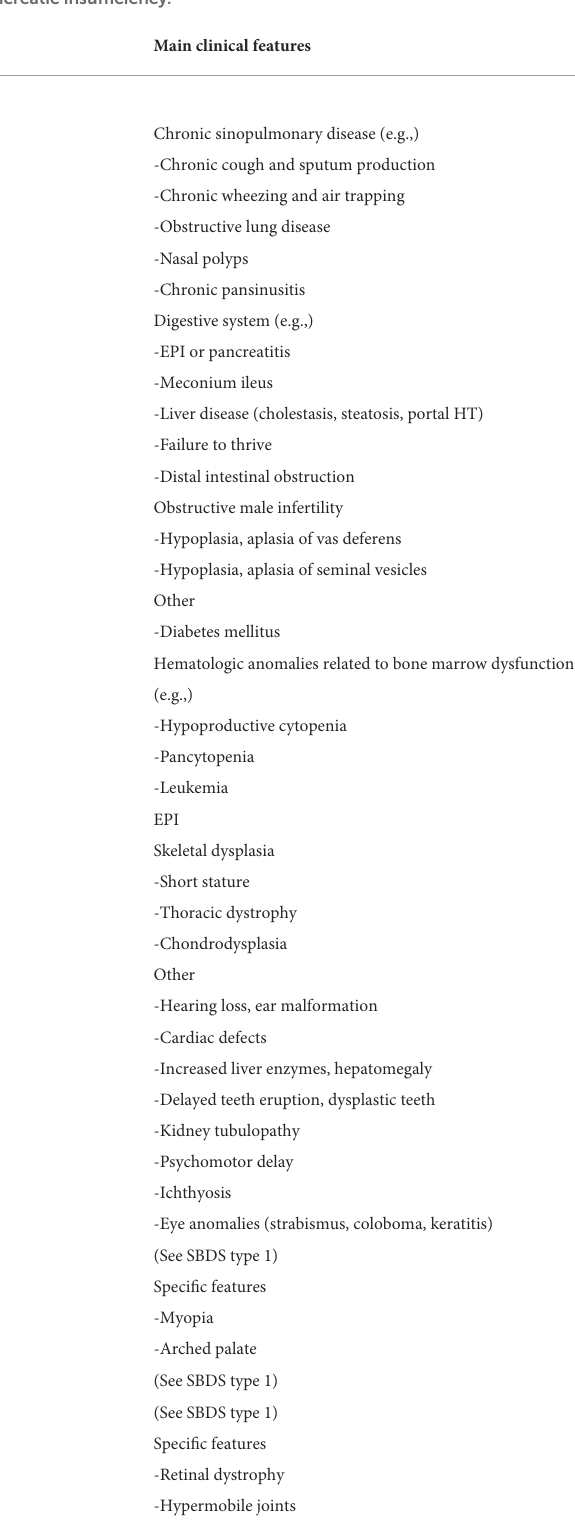
TABLE 1 Etiologies and main clinical features of congenital exocrine pancreatic